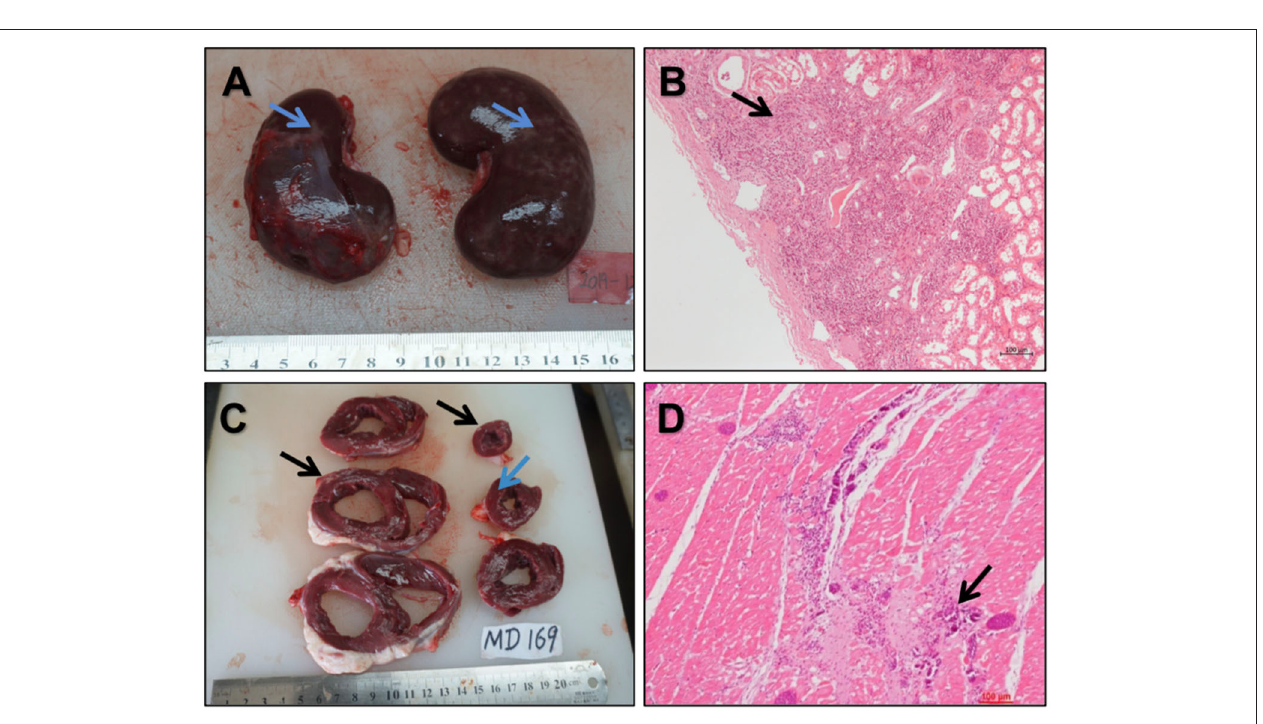
FIGURE 10 | Gross and histological views of the vital organs (A,B) . Gross (A) and histological (B) views of diffused renal infarction ( ↑ ) (C,D) . Anatomic structures of multifocal fibrous scar (C) ( ↑ ) and histopathological examination (D) of multifocal fibrous scar and calcification in the myocardium ( ↑